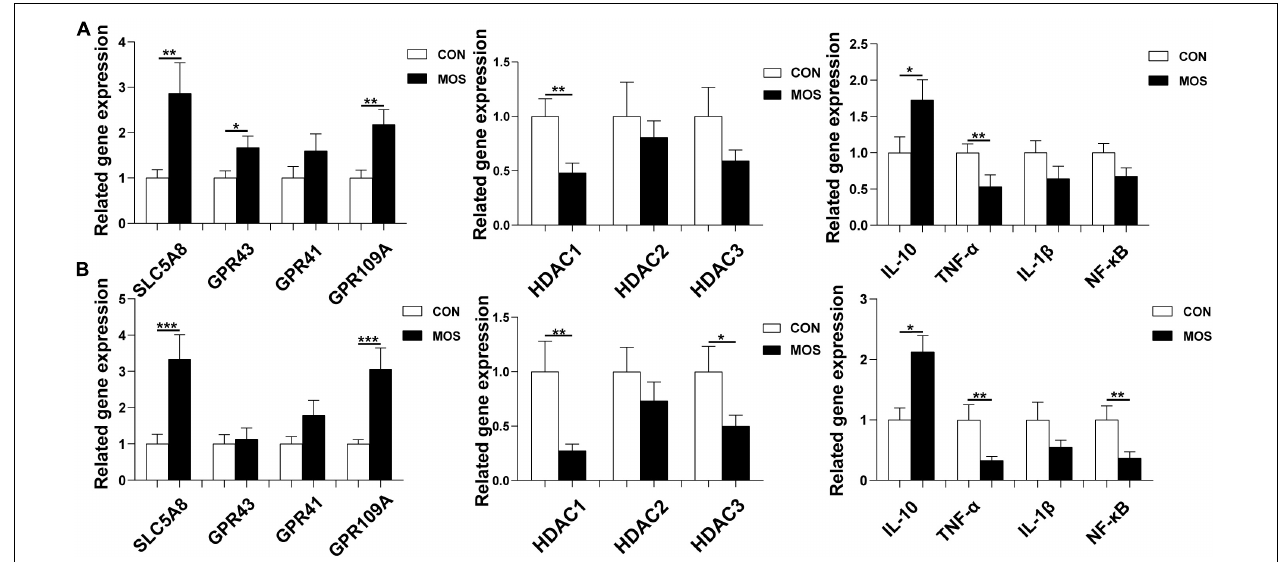
FIGURE 10 | Effect of MOS on expression levels of GPRs, HDACs, and inflammatory cytokines. Ileum (A) and cecum (B) digesta samples were collected from pigs fed with the basal diet (CON) or a basal diet supplemented with 3 g/kg MOS (MOS) ( n = 8). *0.05 < p < 0.1; ** p < 0.05, *** p < 0.01.